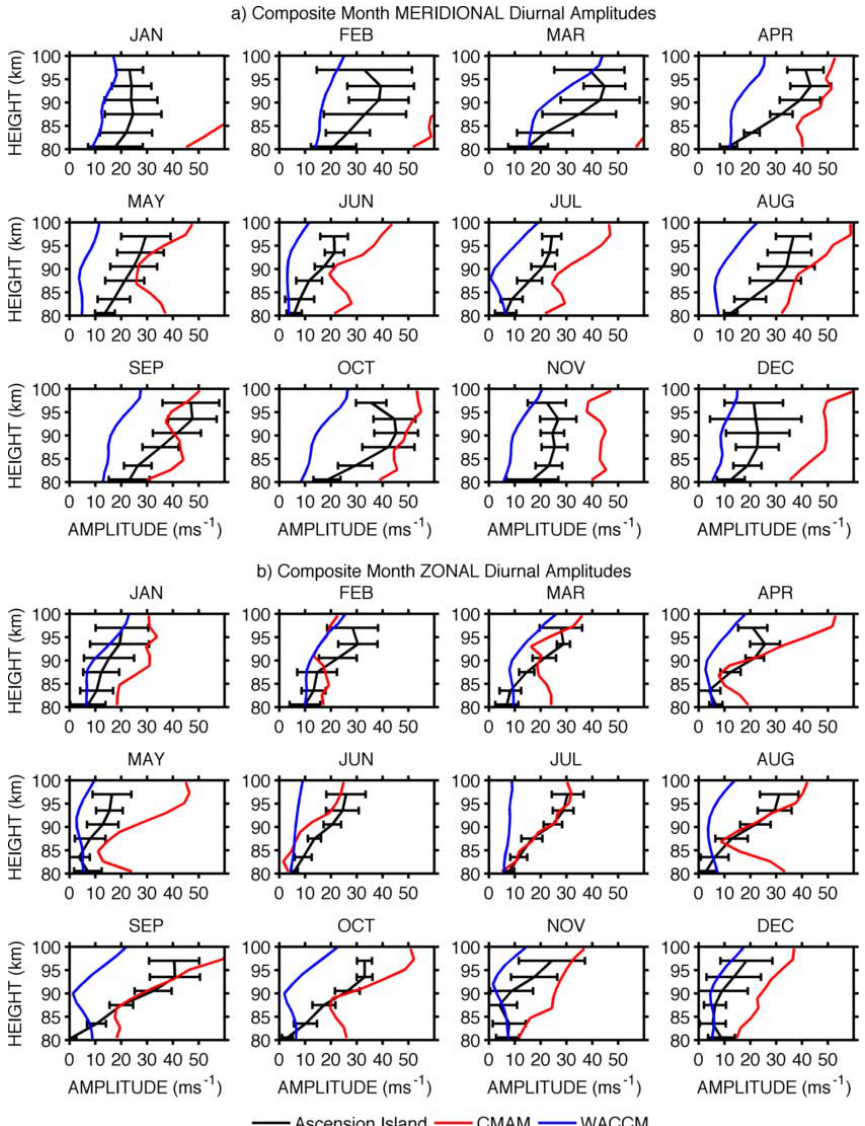
Fig. 7. Amplitudes of the (a) meridional and (b) zonal diurnal tide as a function of month and height. The error bars on the radar observations (black lines) indicate the standard deviation of the individual monthly means over the interval 2002–2011. Also plotted are the predictions of eCMAM (red lines) and WACCM (blue